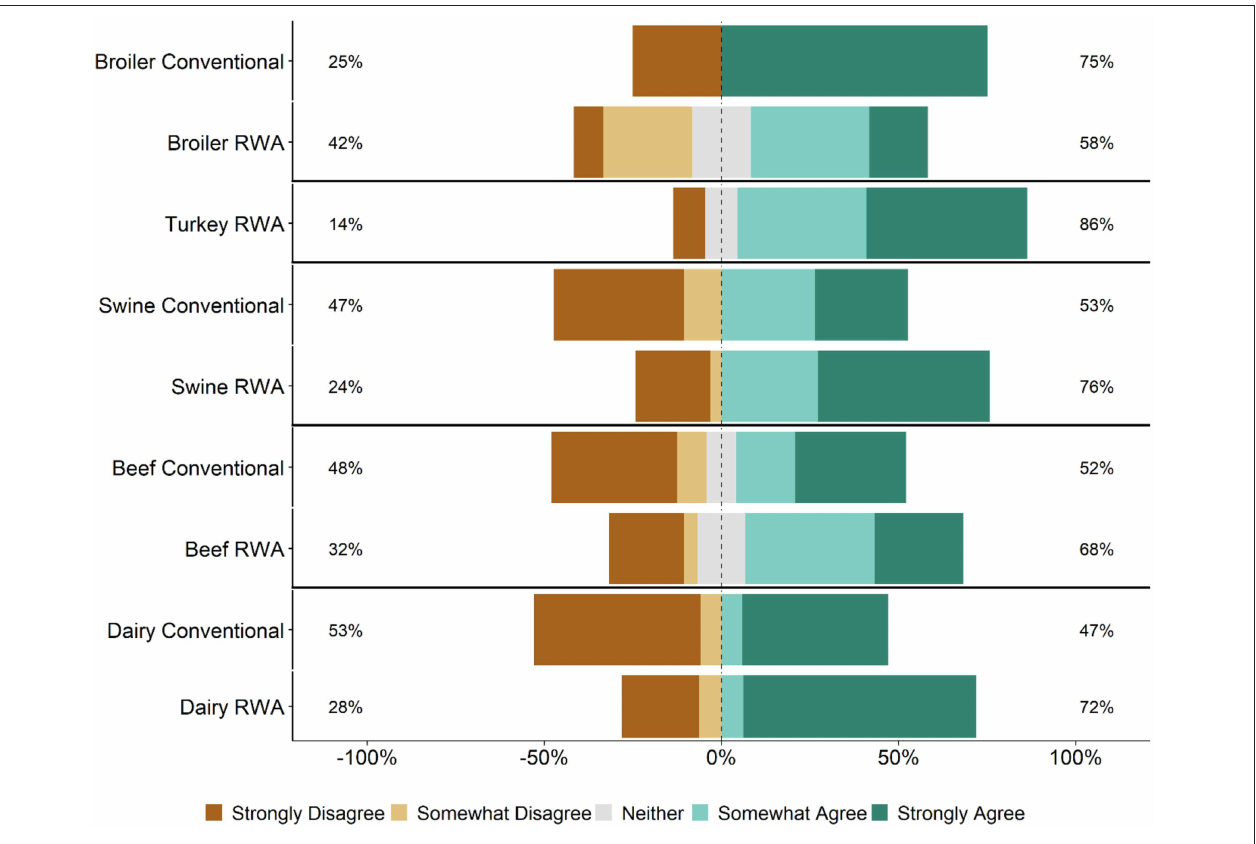
FIGURE 8 | Veterinarian respondents’ opinion about the statement, “There are times that maintaining a Raised Without Antibiotics label has priority over flock/herd health and welfare.” Five-item Likert scale reporting respondents’ opinion, stratified by commodity and RWA